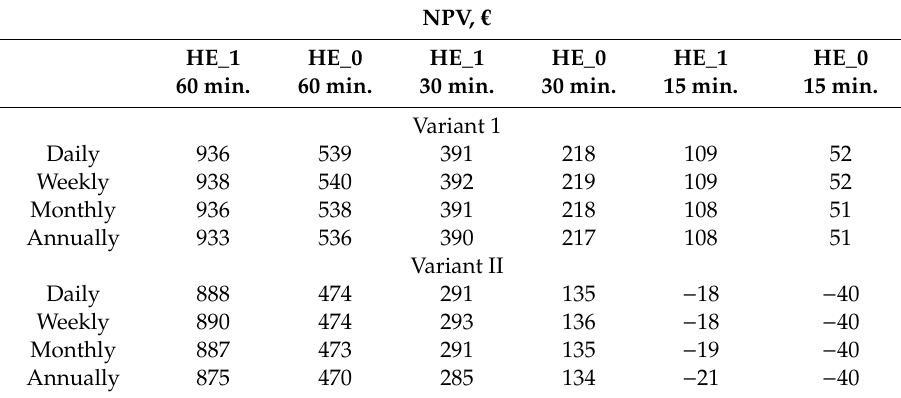
Table 4. Results of NPV analysis for Scenario